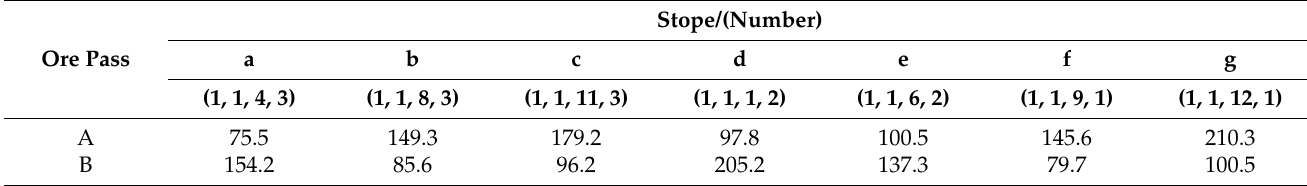
Figure 5. Simple spatial model of ore blocks. The total income during the plan period is 5,325,966 dollars. Table 2. Loaded travel time of the scraper between the stope and ore pass in ( 1, 1 ) sublevel/s (Units: s).